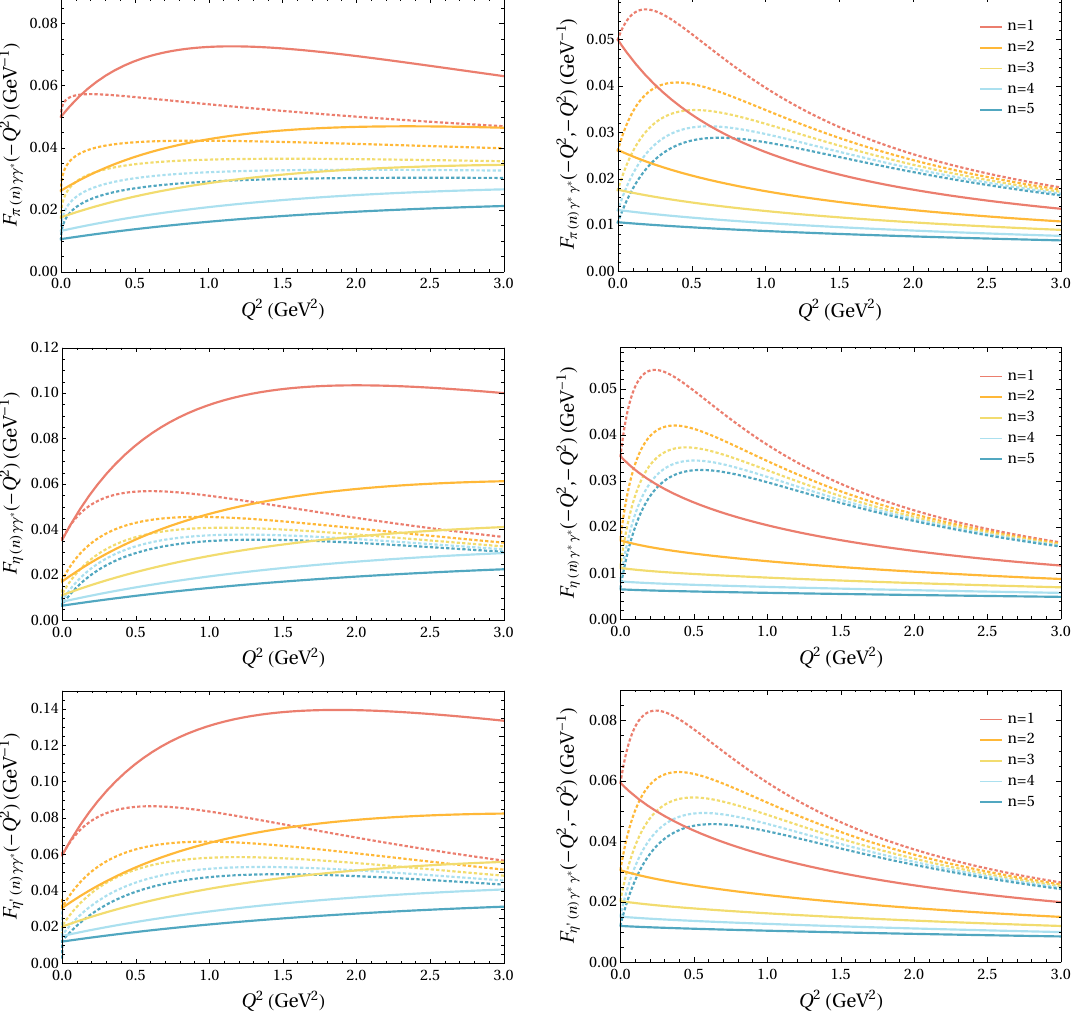
Figure 18. TFFs of the (cid:12)rst n = 1 ; : : : 5 radially excited pion, (cid:17) , and (cid:17) 0 states. Comparison of the large- N c Regge models from section 4, indicated by the solid curves, and our alternative TFF model (B.1), indicated by the dotted curves. The left panel shows the TFFs in the singly-virtual limit, the right panel shows the doubly-virtual region with Q 2